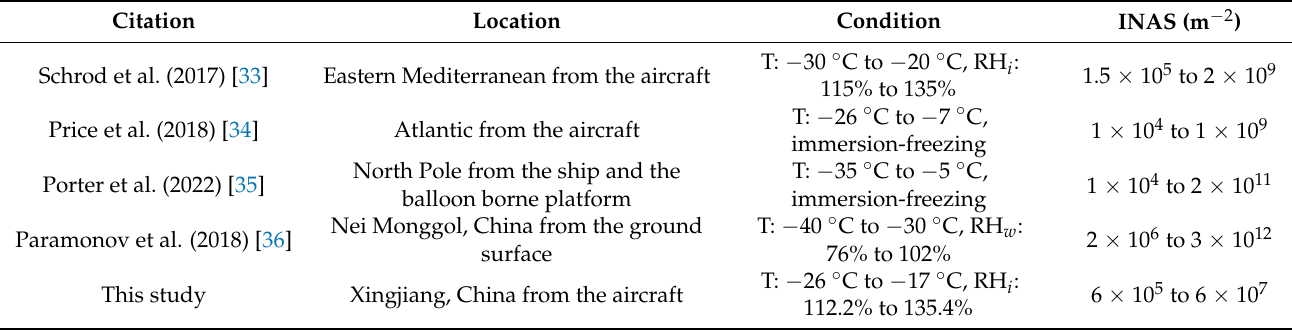
Table 2. Summary of INAS observed in different